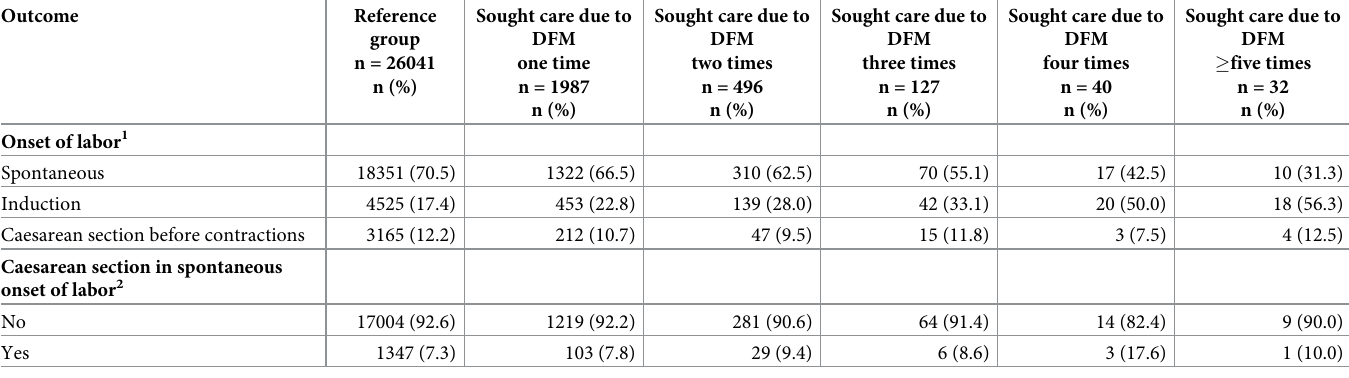
Table 2. Pregnancy outcomes of women who gave birth in 2014 (Reference group) and women who sought care due to decreased or altered fetal movements (DFM group) divided after number of occasions the women sought care.